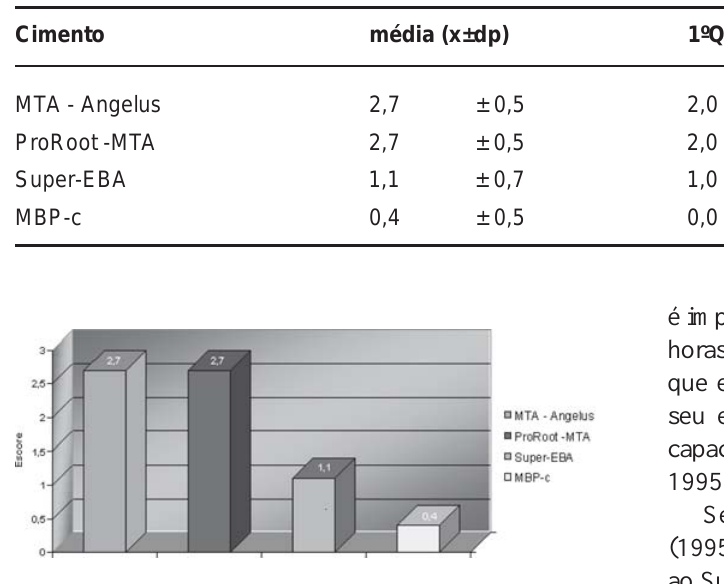
FIGURA 1 - Gráfico representativo das médias dos escores das infiltrações marginais permitidas pelos cimentos testados. ( sem matriz de gesso Paris